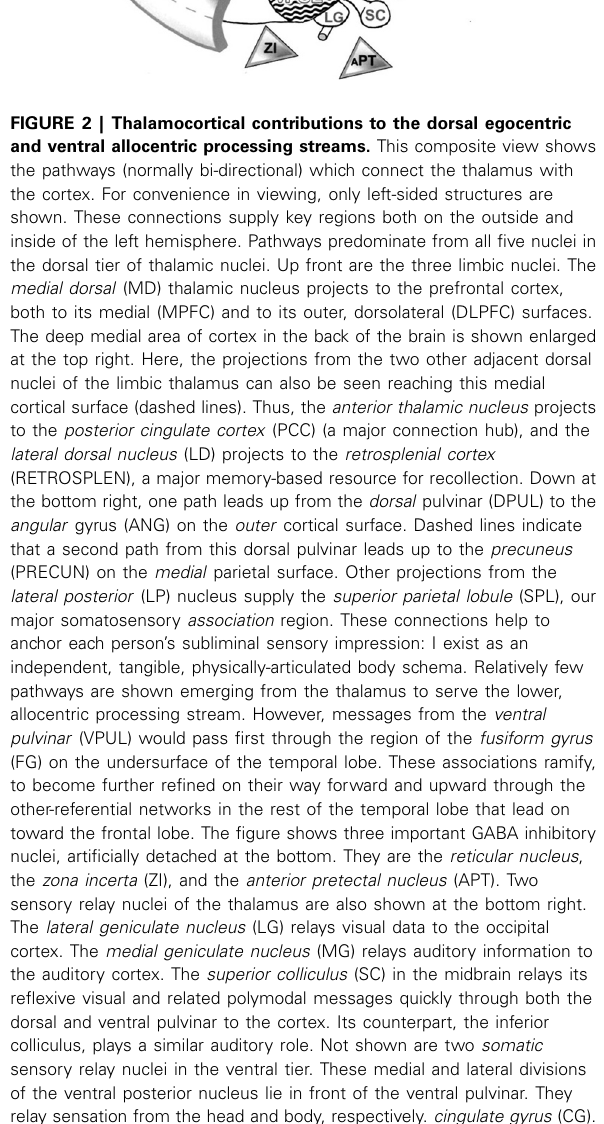
( Figure 2 ). The zona incerta releases its GABA on higher-order thalamic nuclei (including the medial dorsal nucleus). The ante- rior pretectal nucleus projects to both the medial dorsal and lateral dorsal nuclei of the limbic thalamus. It also stands poised to mod- ulate the diversity of relevant functions among the somatosensory, ventral and medial thalamus (Sherman and Guillery,